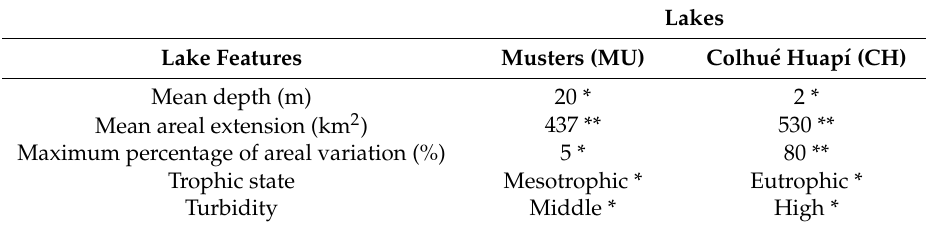
Table 1. Physical and biological features of the Musters and Colhu é Huap í lakes.